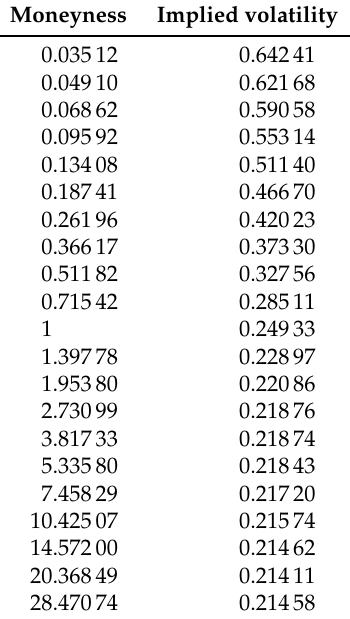
Table A2. Implied volatilities against moneyness K to the example 1 of Jäckel